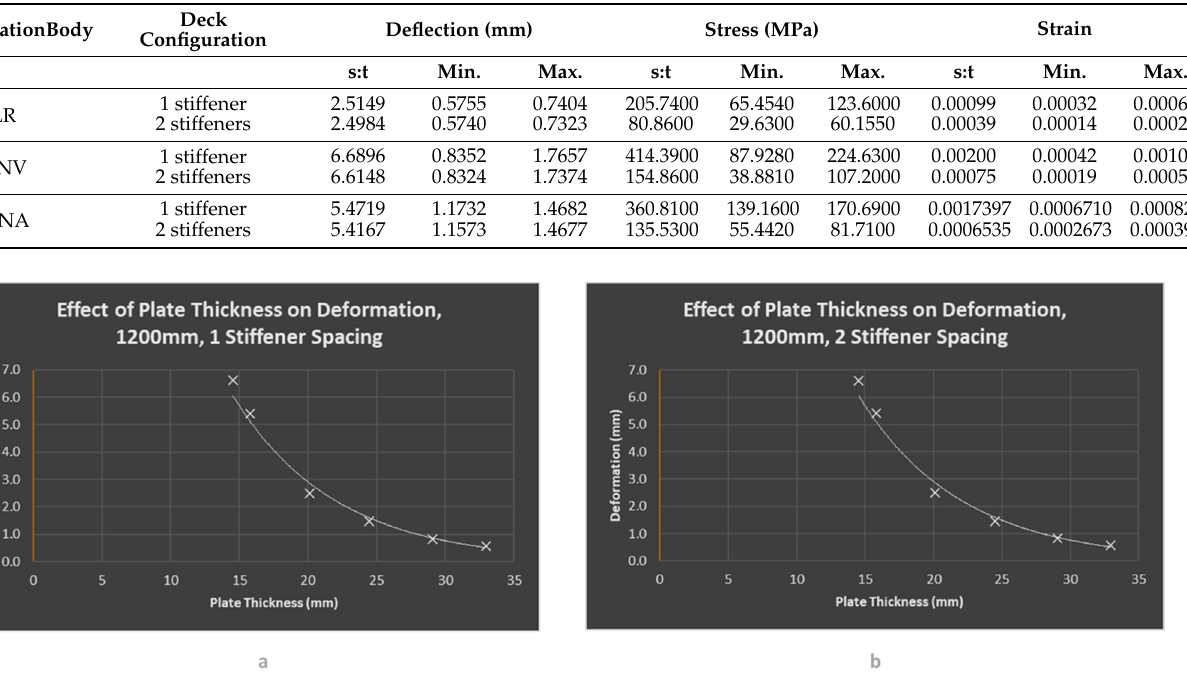
Table 4. Outputs of the FE analyses performed under the UDL condition.